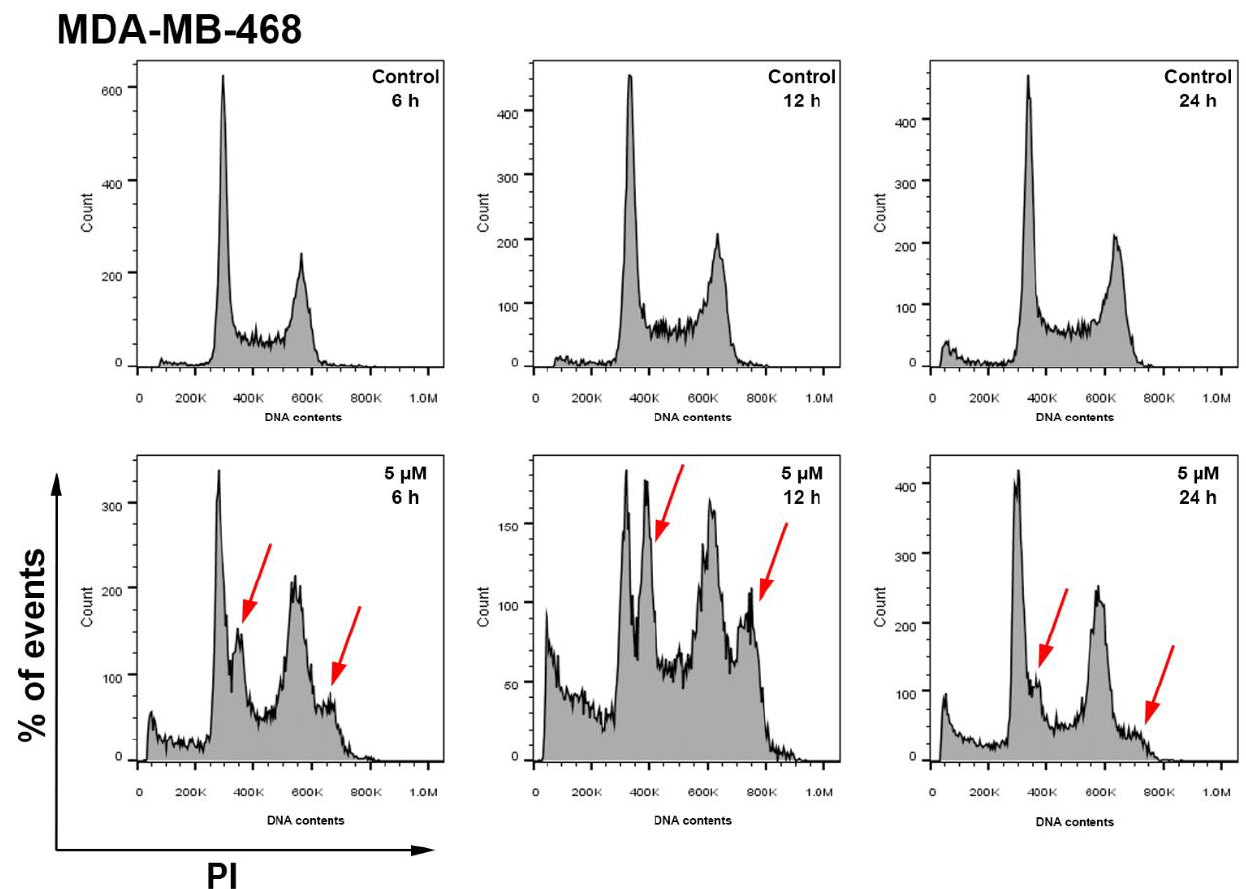
Figure 6. Representative histograms showing the effect of TQ (5 µM) on MDA-MB-468 cell cycle following 6, 12, 24 h exposures. TQ induced significant time-dependent increase in aneuploid cells at G1, S, and G2/M phases after 6 and 12 h with increased pre-G1. After 24 h, pre-G1 and fewer aneuploid cells were observed. Red arrows show aneuploid cells. Cells were stained with PI, and ≥20,000 events/sample were detected. No. trials ≥3; n = 2 per independent experiment.